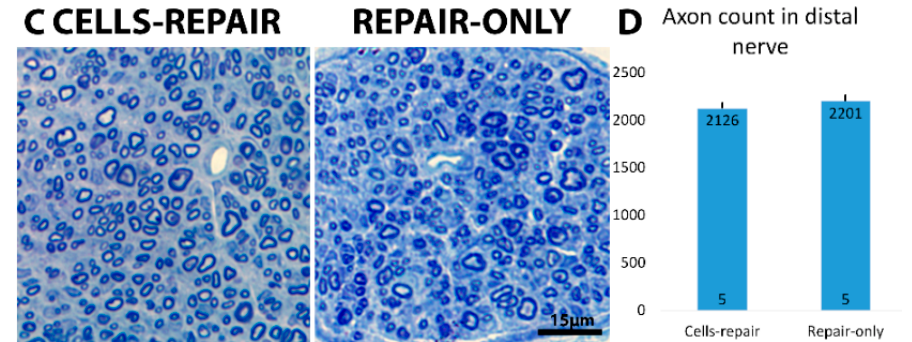
Figure 8. ( A ) Green GFP + axons from the cell graft were seen together with the host regenerating axons in longitudinal musculocutaneous nerve sections; ( B ) Cross sections of the same nerve show the existence of both GFP + NF200 + (from cell graft) and GFP − NF200 + axons (regenerating axons from the host); ( C ) The sectioned segment of the nerve was filled with small, thinly myelinated axons in both the cells-repair and the repair-only group seen from semithin nerve cross-sections with Toluidine blue staining; ( D ) These axons were counted and were expressed as a whole number of axons per nerve. No difference was seen between these two groups. Data is shown as mean + SEM. The number of animals in both groups is shown inside the bar base. The number of animals in both groups is shown inside the bar base.